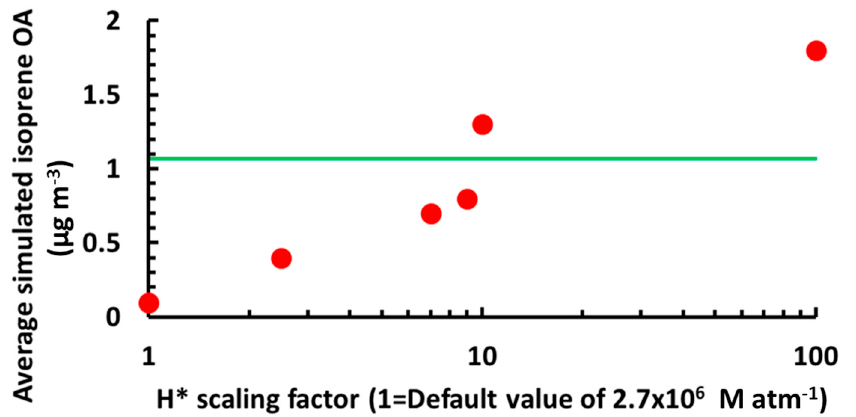
Figure 5. Isoprene organic aerosol (OA) sensitivity to H + from the Henry’s law sensitivity tests. The horizontal axis is in units of 2.7 × 10 6 M atm − 1 , which corresponds to the default H value in Table 2013. CMAQ version. The green line denotes the average observed isoprene OA.